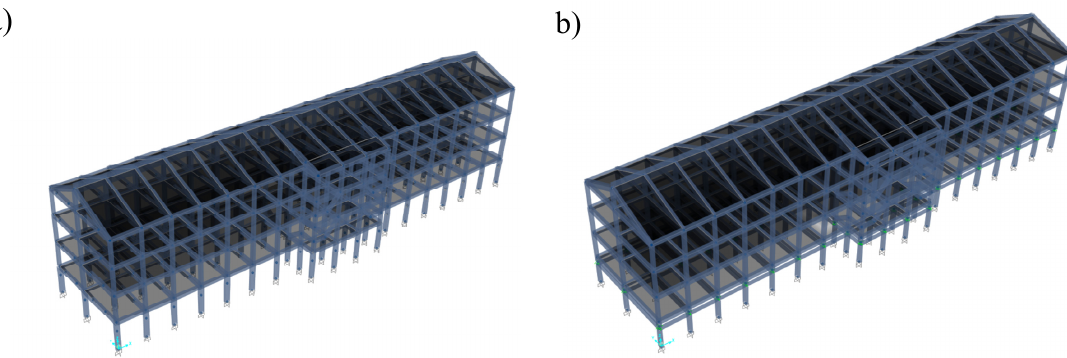
Figure 6. Non-linear numerical models for FB ( a ) and BI ( b ) structure using SAP 2000 [25].